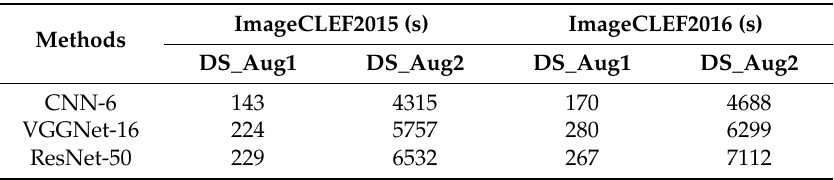
Table 5. Training time of CNNs on augmented